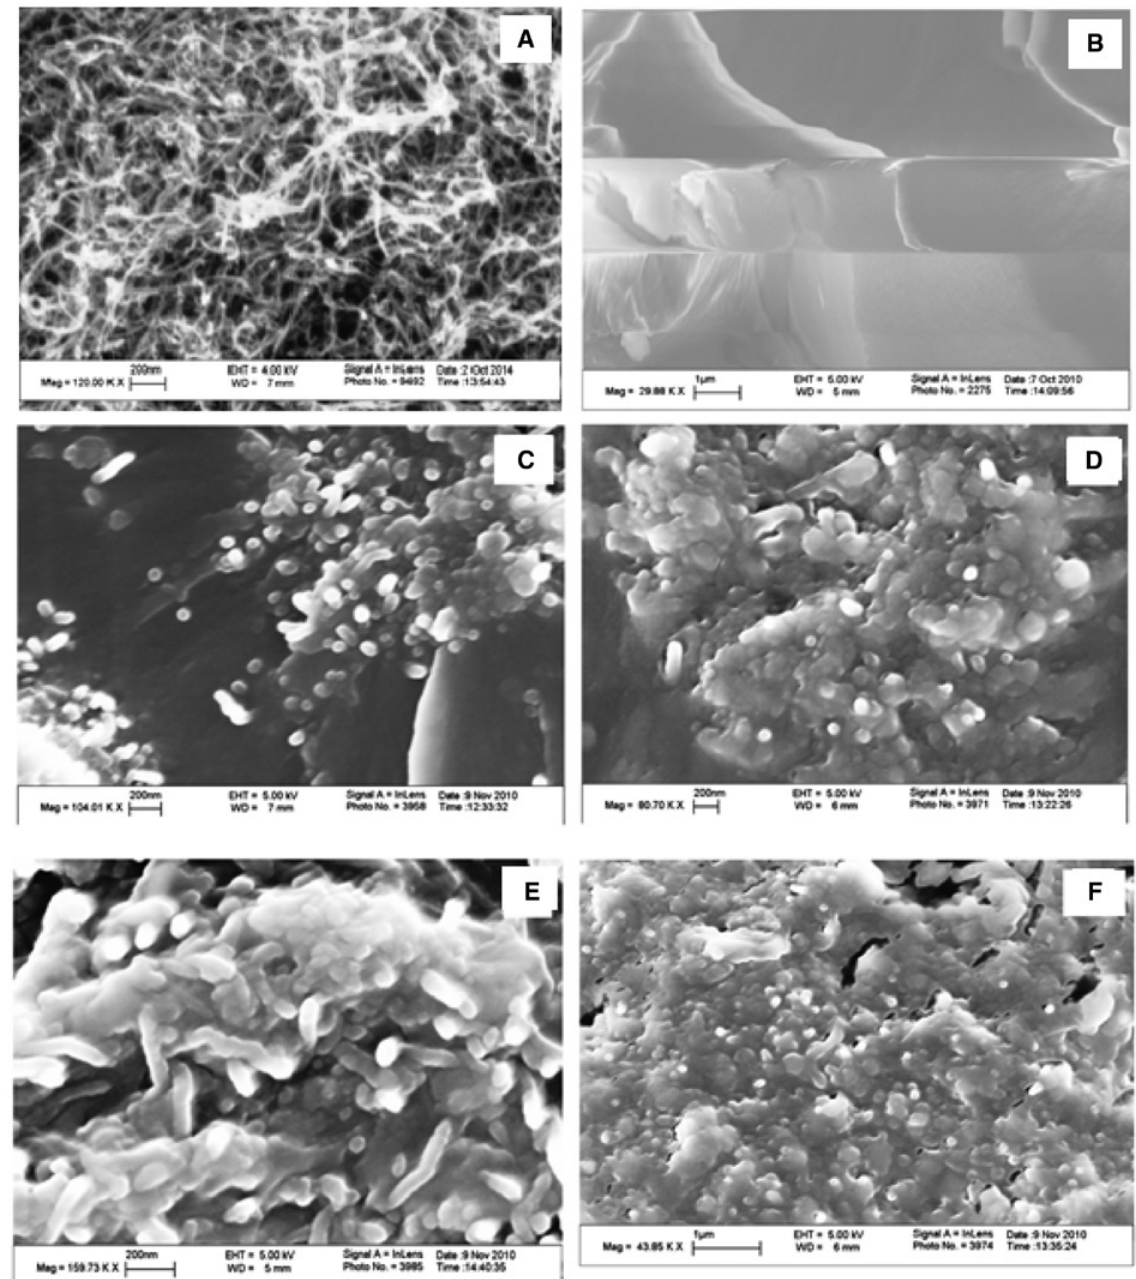
Figure 4: SEM images of (A) CNT-raw; the cross-section image of (B) pure epoxy, (C) epoxy-CNTs-raw composite, (D) epoxy-CNTs-COOH composite, (E) epoxy-CNTs-OH composite, (F) epoxy-CNTs-ODA